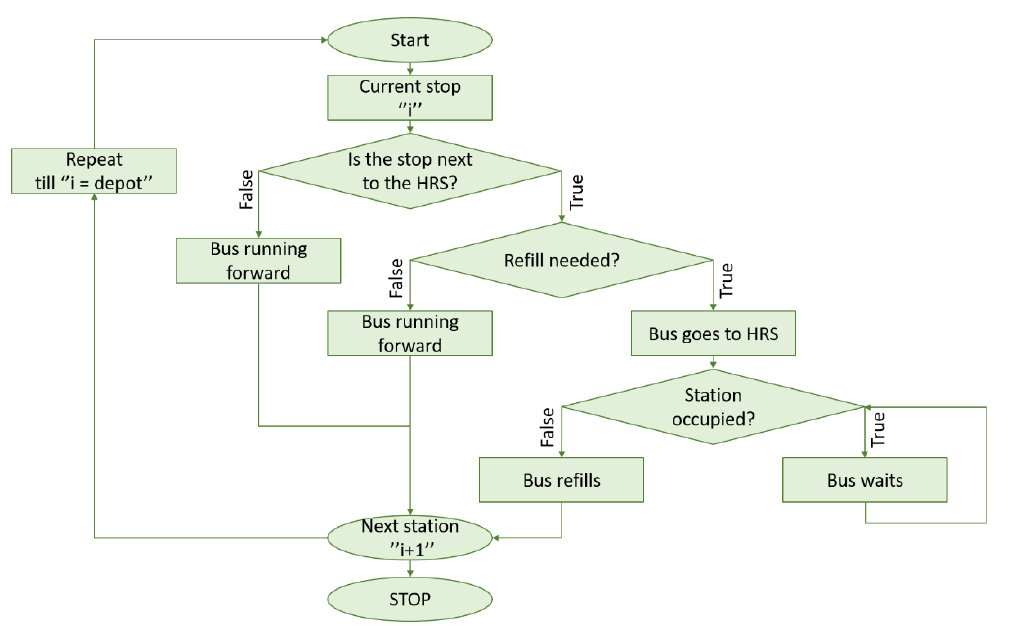
Figure 10. Overview of the logic implemented in the model.